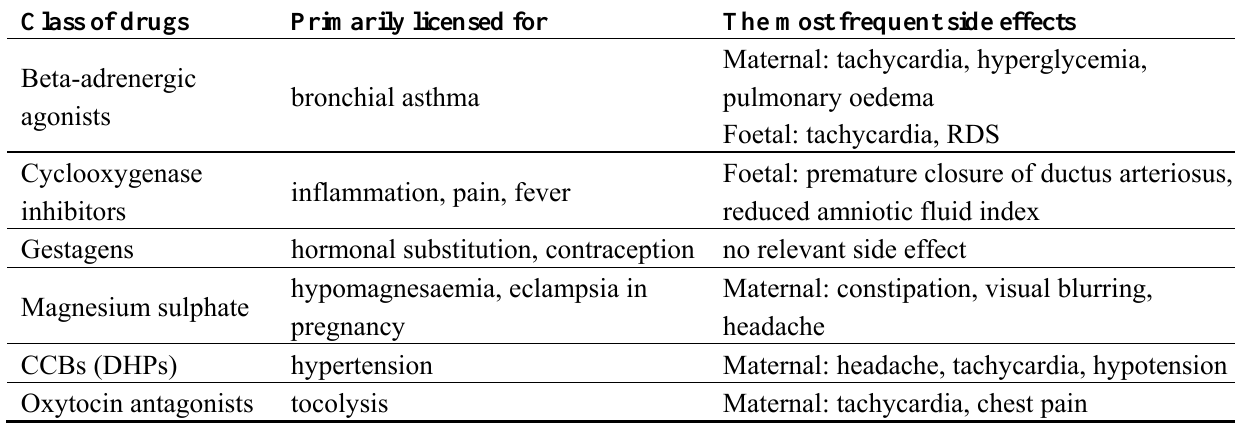
Table 2. Class of drugs used clinically for